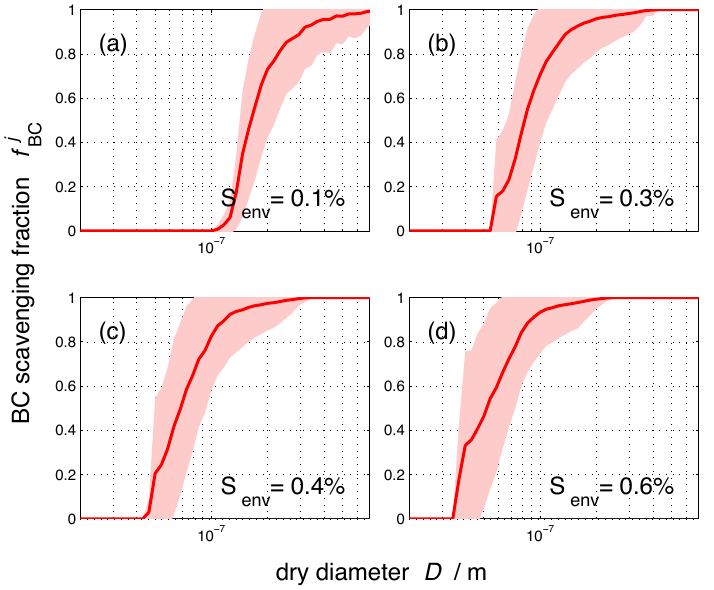
Figure 5. The size-resolved nucleation-scavenged BC mass fraction, f j D , at four selected supersaturation values: 0.1%, 0.3%, 0.4%, and 0.6%. The solid line represents the average over the 384 populations, and the color shading indicates one standard